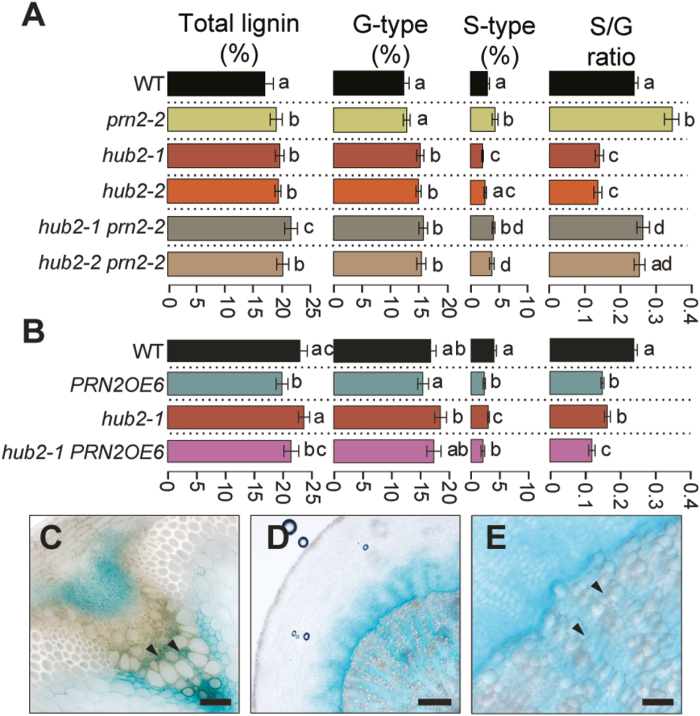
HUB2 affects the lignin content and composition of Arabidopsis hypocotyls. (A, B) The effect of HUB2 and PRN2 on the secondary cell wall composition in Arabidopsis hypocotyls. Py-GC/MS analysis was performed on hypocotyl material collected from 8-week-old prn2-2, hub2-1, hub2-2, hub2-1 prn2-2, hub2-2 prn2-2, PRN2OE6, and hub2-1 PRN2OE6. Relative contents (%) of total lignin, G-type lignin, and S-type lignin are based on their respective MS peak area as a proportion of the cumulative area from all peaks (Gerber et al., 2012). For each genotype, five biological replicates were analysed, each composed of a pool of three hypocotyls. Lines that do not share any letter are significantly different from each other according to post-ANOVA Fisher’s test (P<0.05). Error bars indicate ±SD. (C–E) HUB2 promoter activity. Histochemical β-glucuronidase (GUS) assay was performed on xylem tissues of plants expressing GUS under the control of the HUB2 promoter. (C) Transverse section showing a vascular bundle in an inflorescence stem of a 6-week-old plant. (D, E) Transverse section from the hypocotyl of an 8-week-old plant. (E) Is a magnified image from (D). Arrowheads indicate xylem cells adjacent to lignifying vessel elements. The scale bar represents 100 µm (C, E) or 500 µm (D).